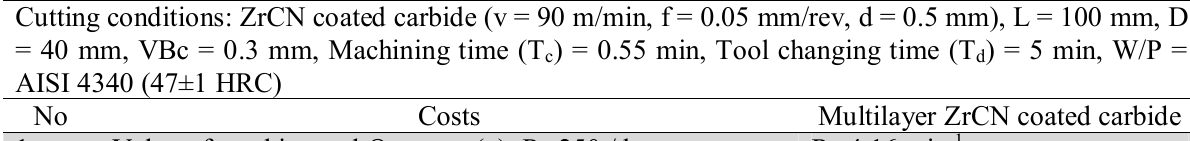
Machining cost per part in hard turning Cutting conditions: ZrCN coated carbide (v = 90 m/min, f = 0.05 mm/rev, d = 0.5 mm), L = 100 mm,